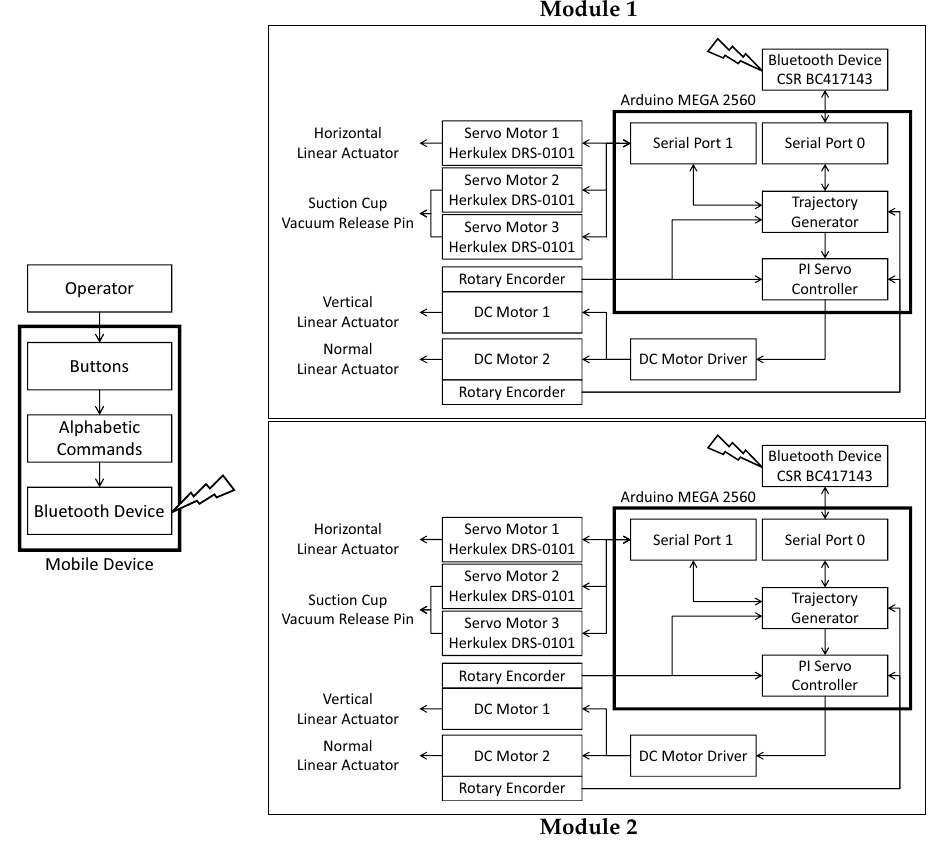
Figure 13. Diagram of system architecture. Battery of 11.4 V supply to the DC motors via the DC motor driver. One of 7.4 V supply to the servo